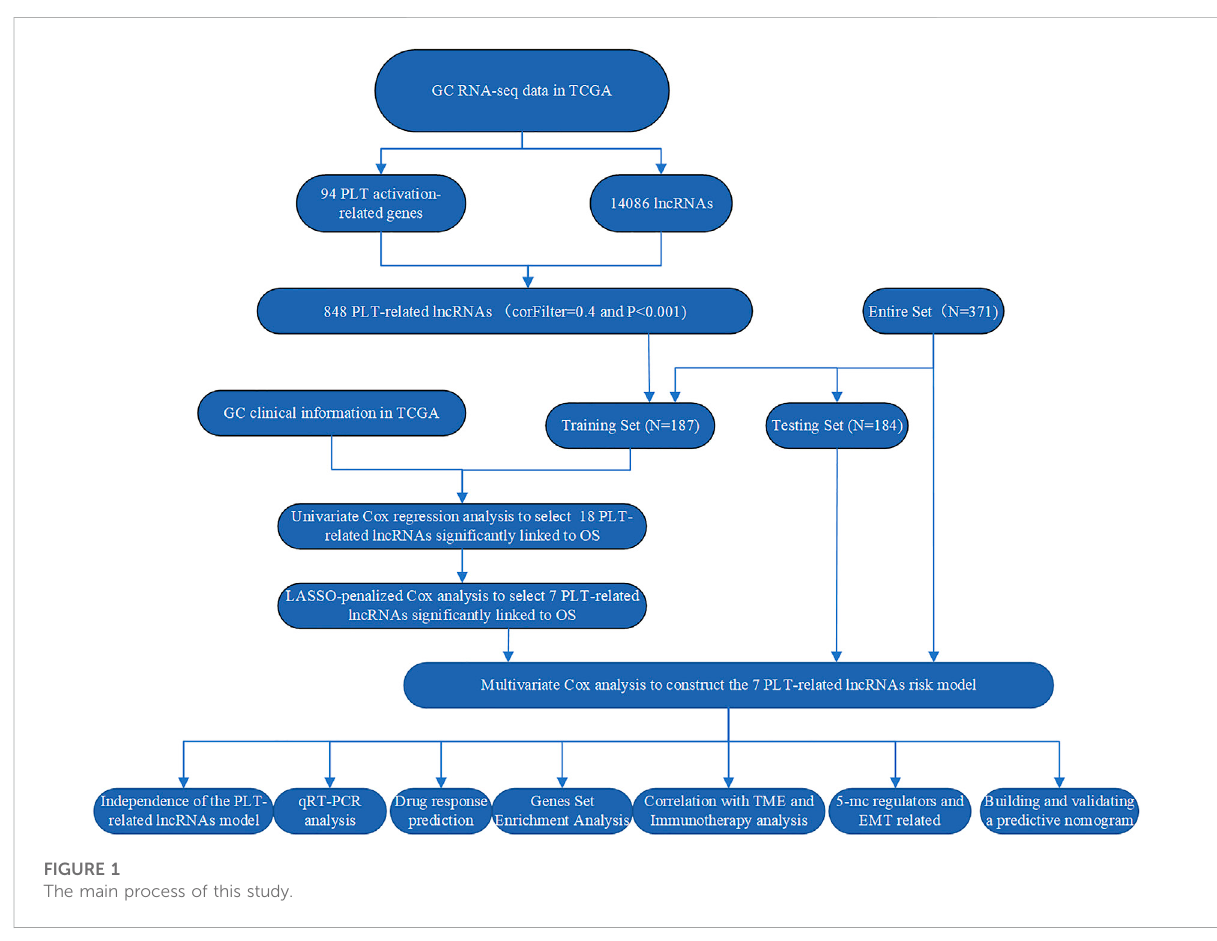
FIGURE 1 The main process of this